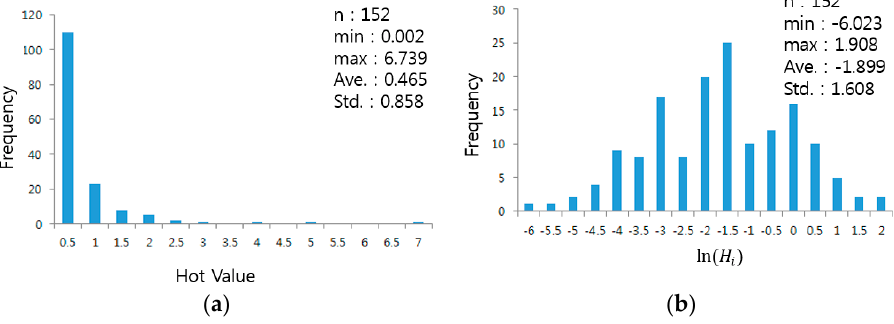
Figure 7. Test area histograms: ( a ) distribution of H i ; (b) distribution of natural logarithm value of H i